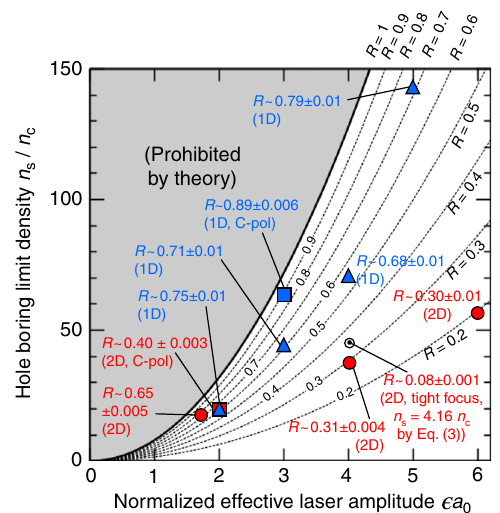
Fig. 3 Dependence of the hole boring limit density n s on the normalized ffiffiffi p effective laser fi eld amplitude ϵ a 0 . Here, ϵ = 1 and 2 for linear and circular polarizations, respectively. Theoretical lines given by Eq. (4), that is for the 1D relativistic condition α = 1 and β h = 1, are presented by black solid and dotted lines for various re fl ectivities R . The shaded area corresponds to that prohibited by the theory for any re fl ectivity R . Blue triangles and blue square show the PIC simulation results for one-dimensional geometry with linear and circular polarizations, respectively. Red circles and red square are the 2D PIC simulation results for the quasi-1D geometry with widely focused (spot size of 60 μ m) linear-P and circular polarizations, respectively. The white circle corresponds to the PIC simulation result for a tightly focused (spot size of 1.5 μ m) P-polarized laser pulse in two-dimensional geometry, for which the corresponding theoretical value of n s assuming the 2D relativistic condition α = 2 and β h = 1 in Eq. (3) is presented. Re fl ectivity R obtained in each simulation is also